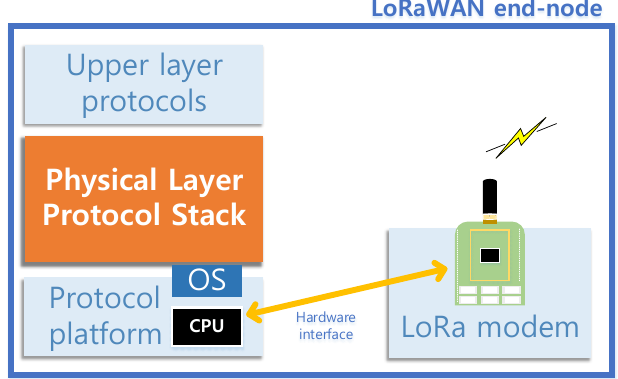
Figure 1. The system architecture of the LoRaWAN